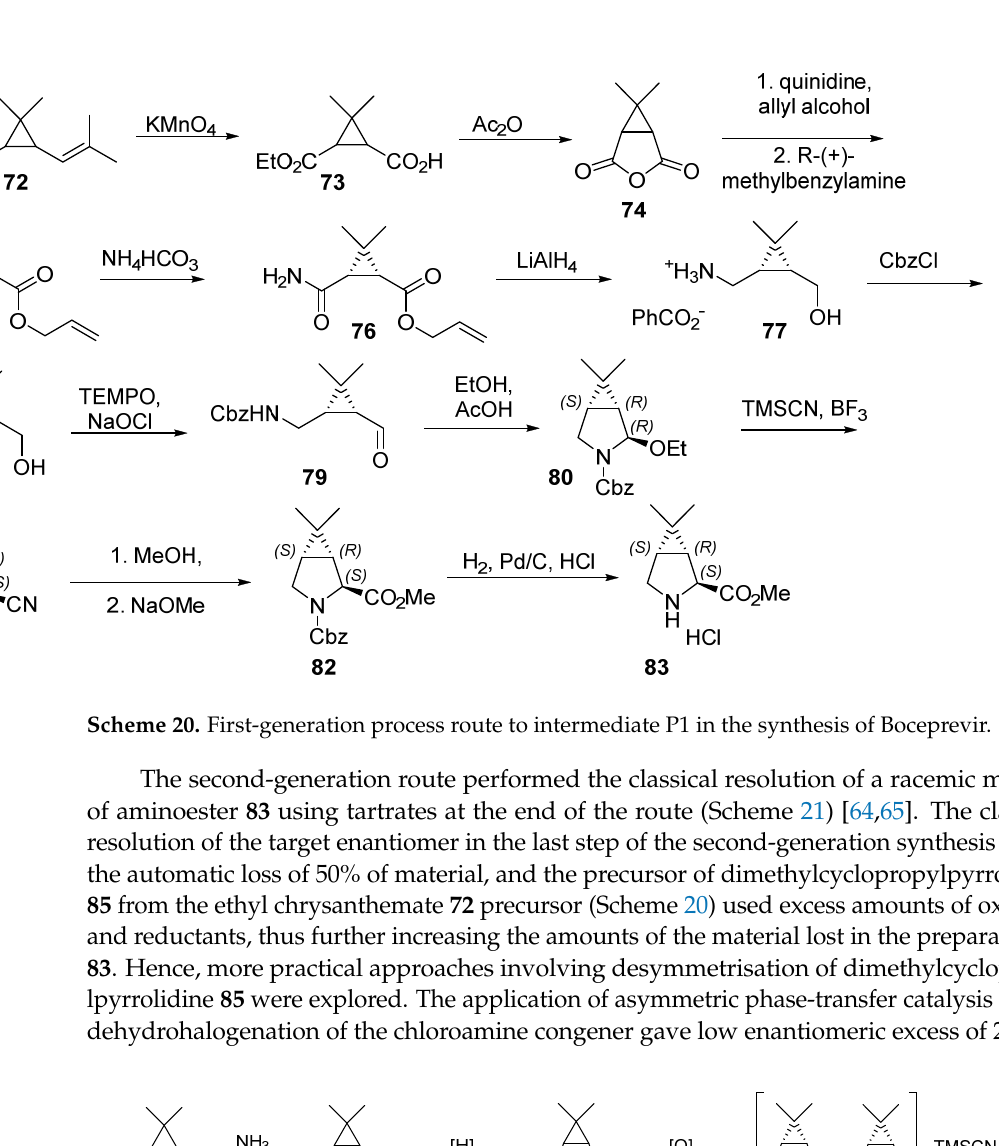
P1 P3Cap Figure 1. Structure of Boceprevir. The hydrochloride salt of the dimethylcyclopropylproline methyl ester, being the precursor for the P2 unit, was originally prepared on a large scale using caronic acid 74